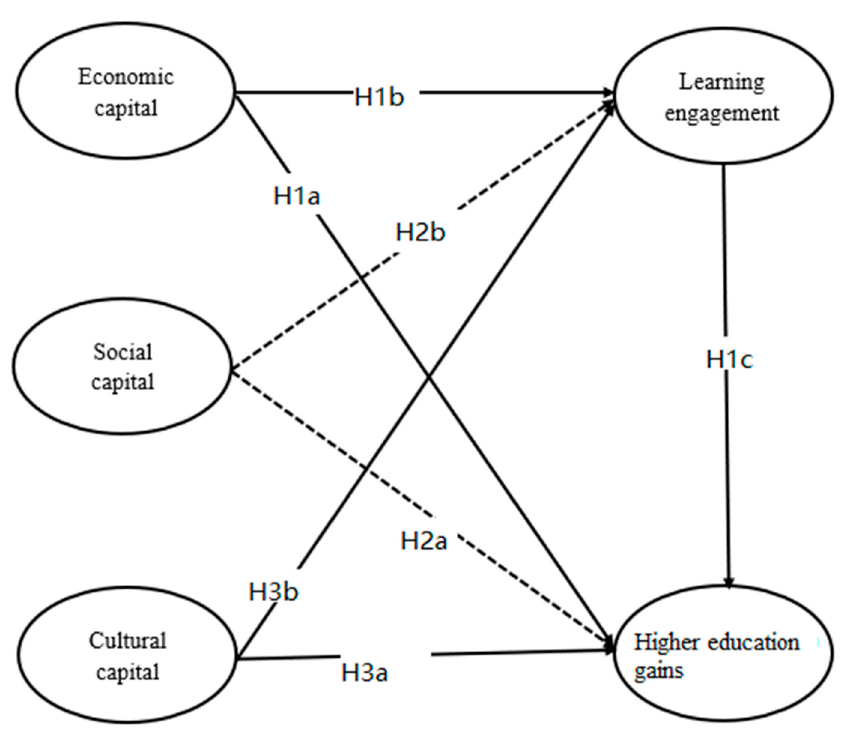
Figure 1. Analytical framework.